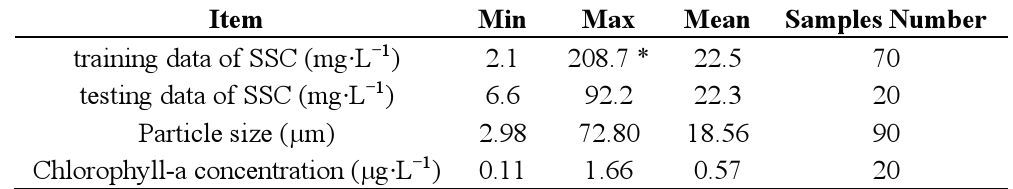
Table 1. The statistics of the measurements of the study area, including two groups of in situ SSC dataset of 90 locations: One group is the dataset of 70 samples to establish the retrieval model (training data); another group is the dataset of 20 samples to validate the model (testing data); particle size dataset and chlorophyll-a concentration